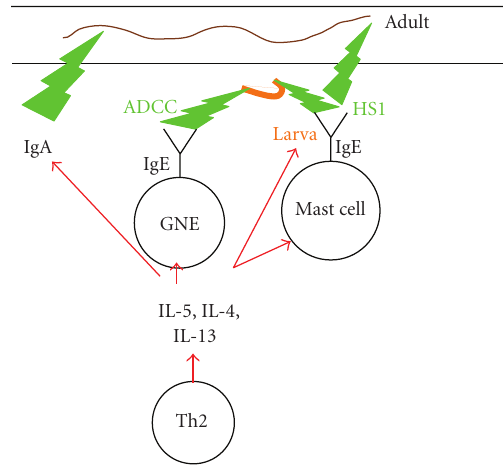
Figure 3: Immune response against gastrointestinal nematodes (GNE: eosinophil granulocyte, HS1: type 1 hypersensitivity). Against larva, ADCC and type 1 hypersensitivity are involved to block their migration in gut mucosa and to eliminate the